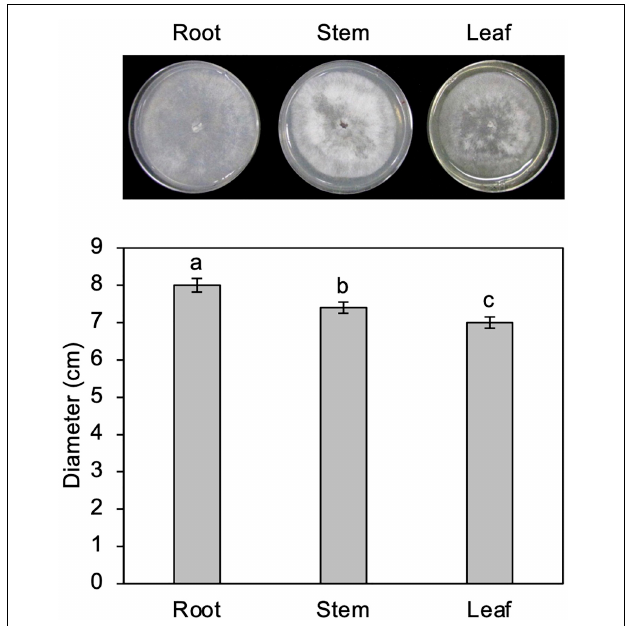
FIGURE 3 | Growth of Calonectria ilicicola in culture media containing extracts from roots, stems, and leaves. Representative images (upper panel) and average mycelial growth (lower panel) were taken after 2 weeks of culturing. Different letters indicate significant differences (Turkey’s multiple comparison test, p <